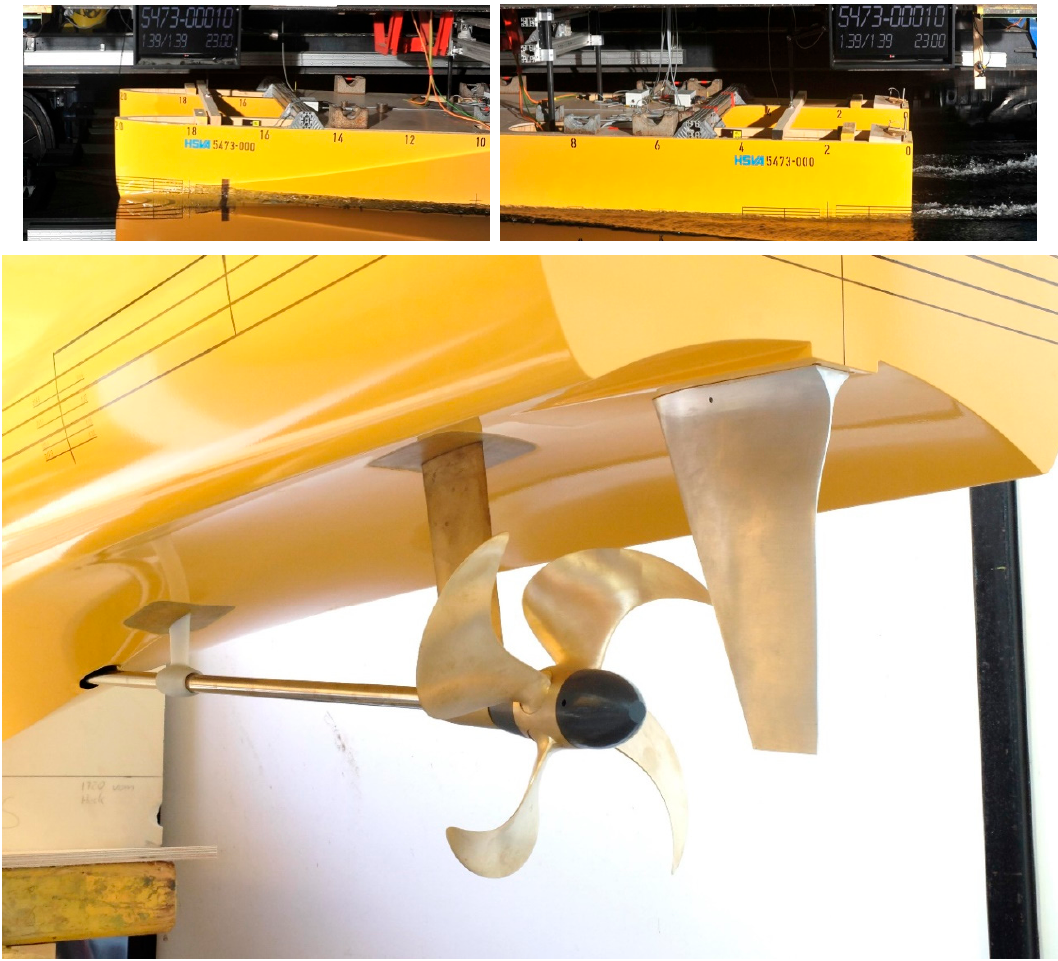
Figure 6. Stavanger demonstrator model at Froude number 0.69 ( up ) and close-up of its stern area ( down ) with fitted propellers, shafts, brackets and rudders.